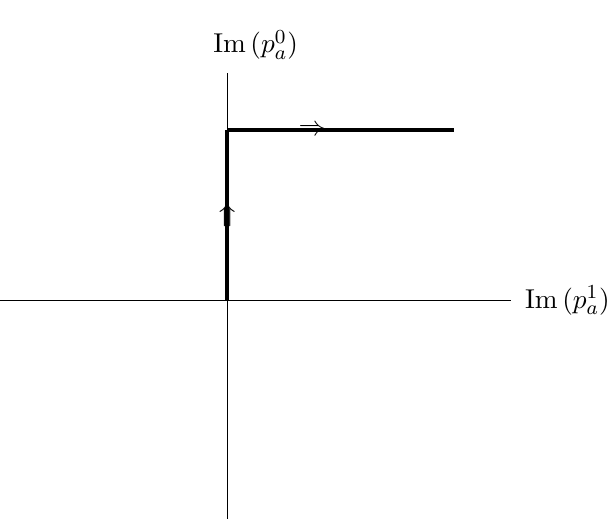
Figure 2 . A schematic representation of the deformation of the external momenta that we follow in the Im ( p 1 )-Im ( p 0 ) plane. In the (cid:12)rst step we deform all components of momenta except Im ( p 1 a a to their desired values along a straight line. This has been represented by the thick vertical line. In the second step we deform Im ( p 1 ) to their desired values along a straight line keeping (cid:12)xed all a other components. This has been shown by the thick horizontal